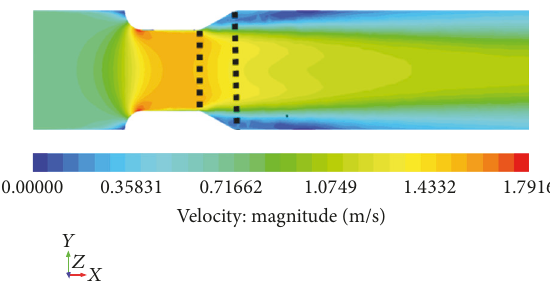
Figure 13: Short diffuser geometry and its velocity distribution.